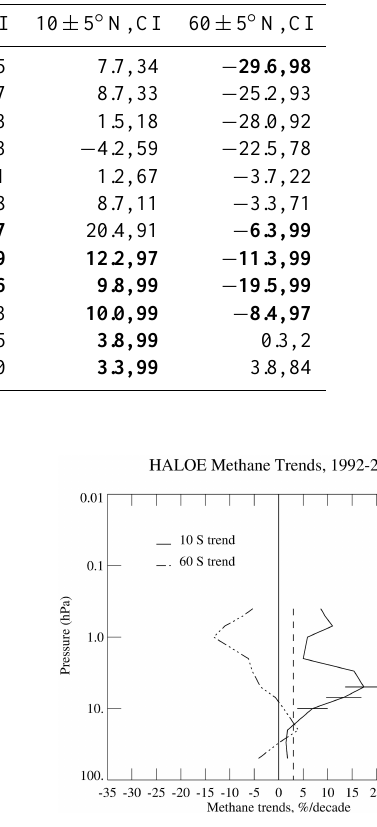
Figure 8. Tropical and high-latitude trend profiles for CH 4 in the Southern Hemisphere. Vertical dashed line is the approximate trend for tropospheric CH 4 or 3.0 ± 0.7%decade − 1 . Horizontal bars show the 2 σ error estimates for the highly significant trend